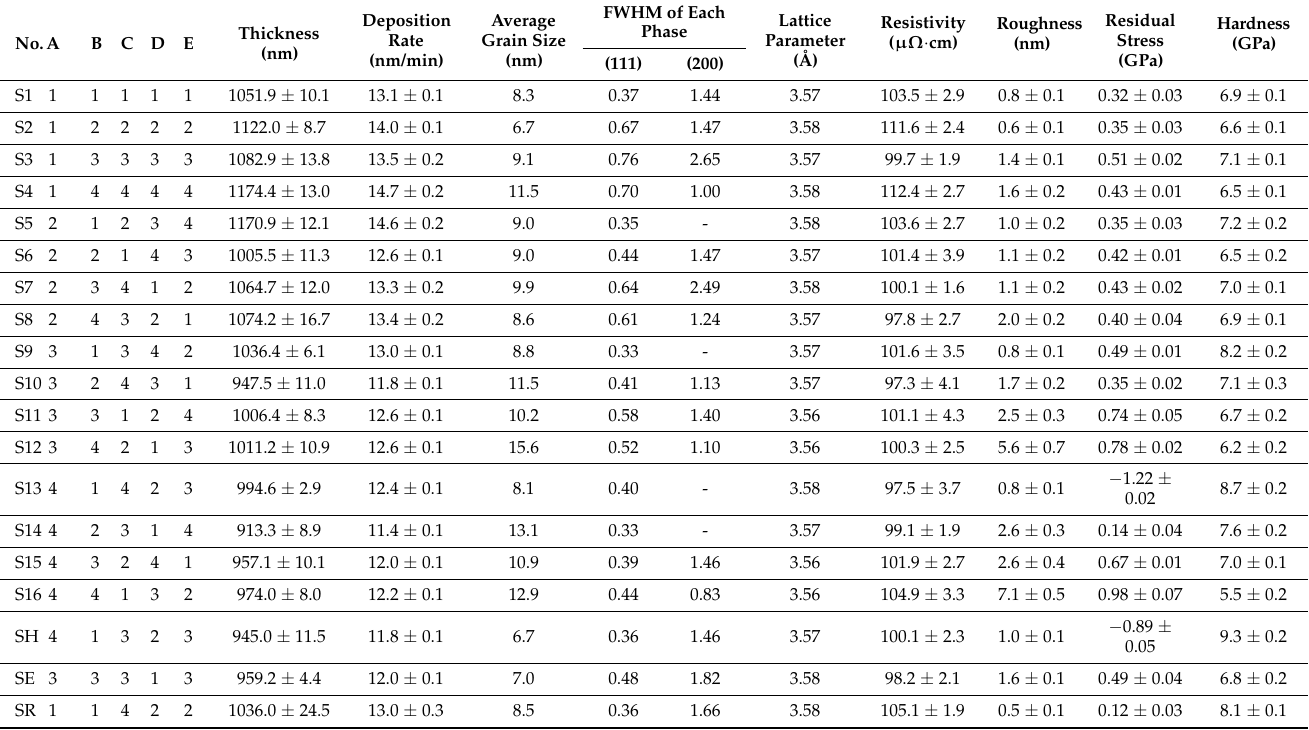
Table 2. Experimental orthogonal arrays and summary results of each thin